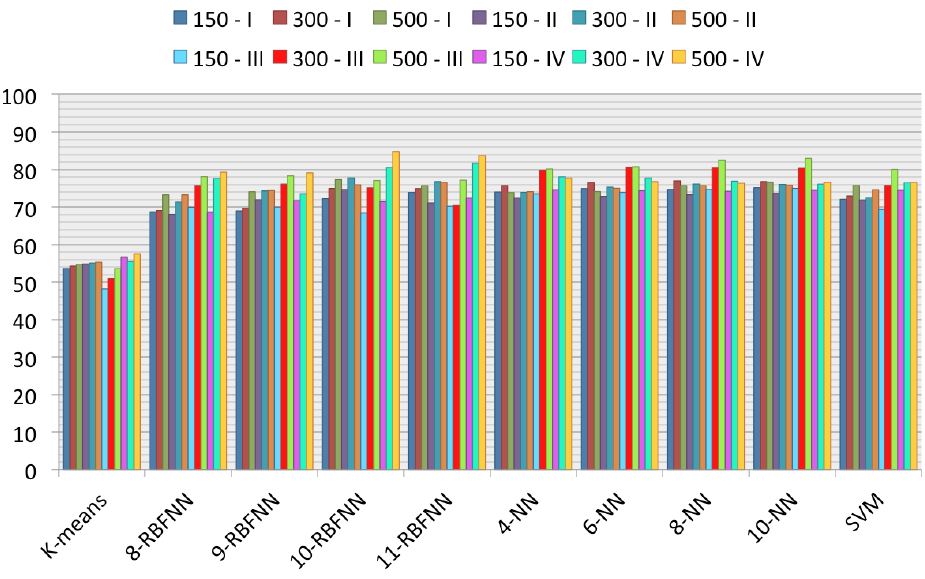
Figure 15. Overall success rates for the original patches depending on the classifier (horizontal axis), the patch size (150, 300 or 500) and the parameters set (I, II, III or IV; defined in Section 6).